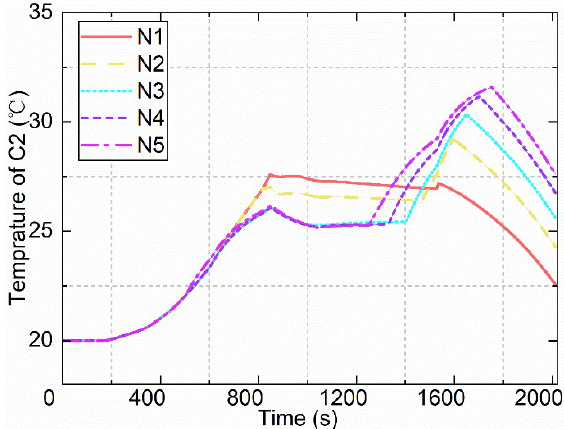
Figure 12. Temperature of different nodes in C2.